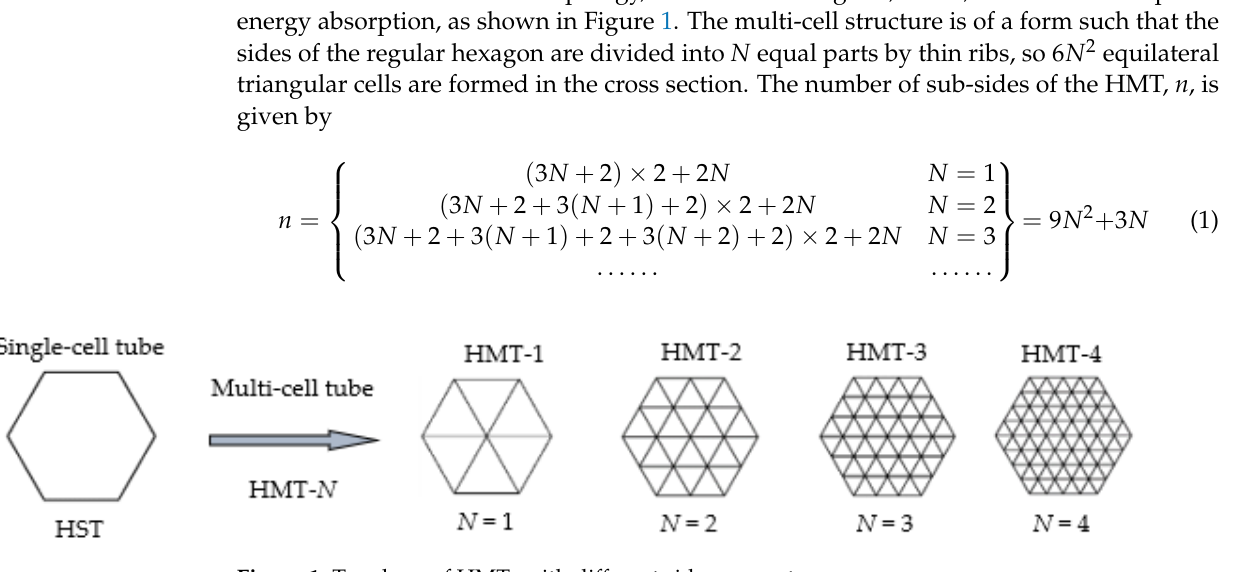
HMT-2b Figure 2. Manufactured thin-walled steel hexagonal tubes. The stress – strain curve of steel Q235 is shown in Figure 3 and listed in Table 2 [19]. The plastic stress is the average of the initial yield stress and the ultimate stress.